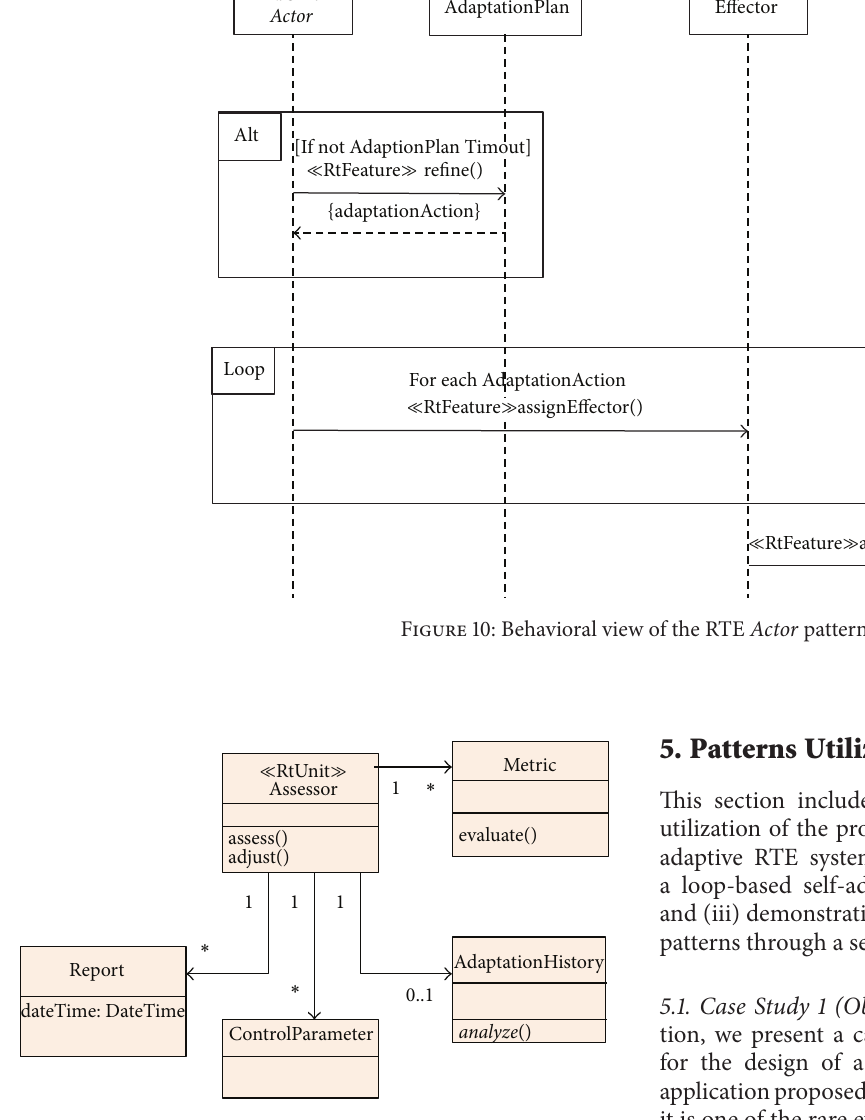
Figure 11: Structural view of the RTE Assessor